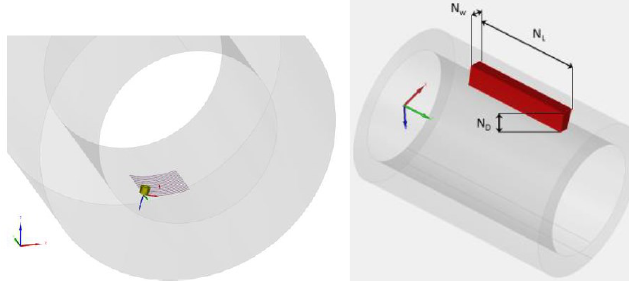
Fig. 14. Scanning pattern in eddy current simulations with geometrical explanation of Table III variables. T ABLE III D EFECT MESH POINTS IN THE EDDY CURRENT LIFT - OFF VARIATION